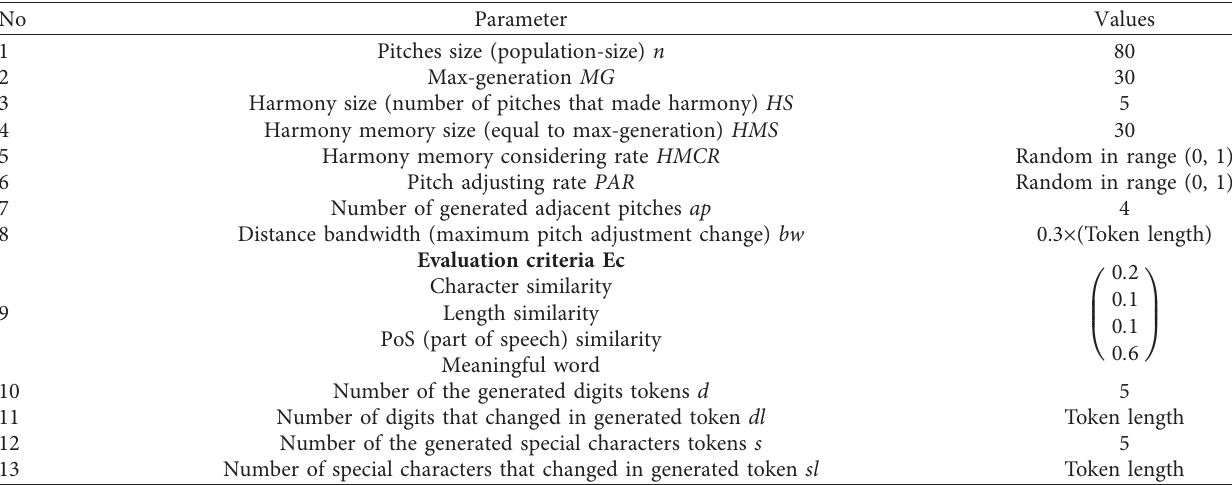
Table 1: The HSA parameters values.